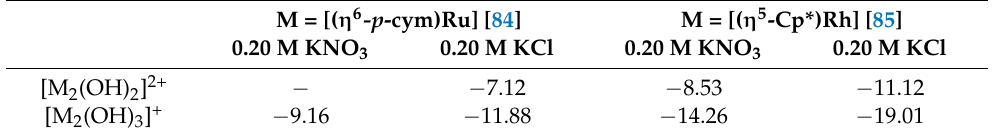
Table 2. Thermodynamic (log β ) and conditional stability constants (log β *) of [(η 6 - p -cym)Ru(H 2 O) 3 ] 2+ and [(η 5 -Cp*)Rh(H 2 O) 3 ] 2+ hydroxido complexes at 25.0 °C and I = 0.20 M KNO 3 and KCl, respectively.